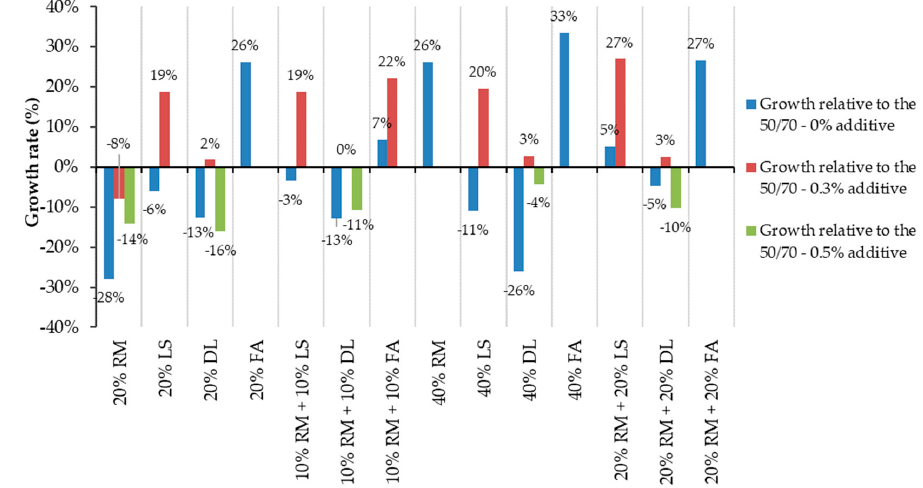
Figure 10. The growth rate relative to the reference sample.